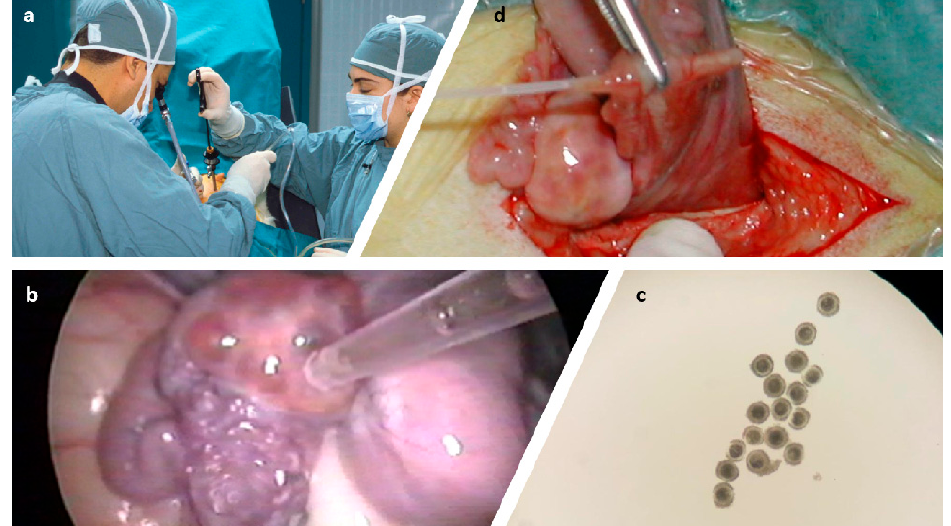
Figure 1. Laparoscopic ovum pick-up (LOPU) in goats: ( a ) three ports are inserted into the goat— one for the laparoscope, one for the grasping forceps, and one for the aspirating pipette/needle; ( b ) endoscopic view showing the column of follicular fluid aspirated into the pipette as the needle perforates the follicular wall; ( c ) oocytes recovered with moderate preservation of cumulus cells; and ( d ) oviduct transfer of early staged embryos.